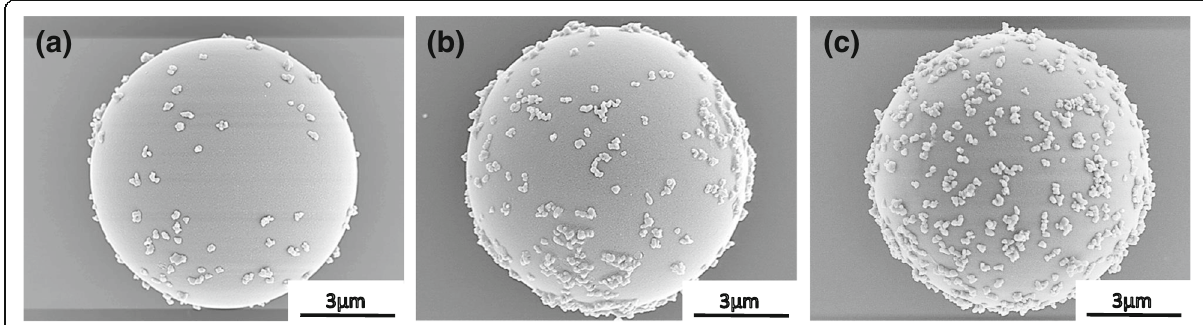
Fig. 5 SEM images of the Al 2 O 3 -SiO 2 composite particles that were mixed and stirred for a 5, b 15, and c 60min, respectively, with a fixed additive particle amount of 25% coverage